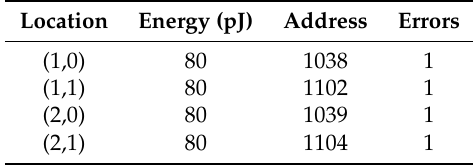
Figure 4. Schematic of SRAM words in a SRAM block. Table 2. Generated errors and corresponding address from a SRAM block.